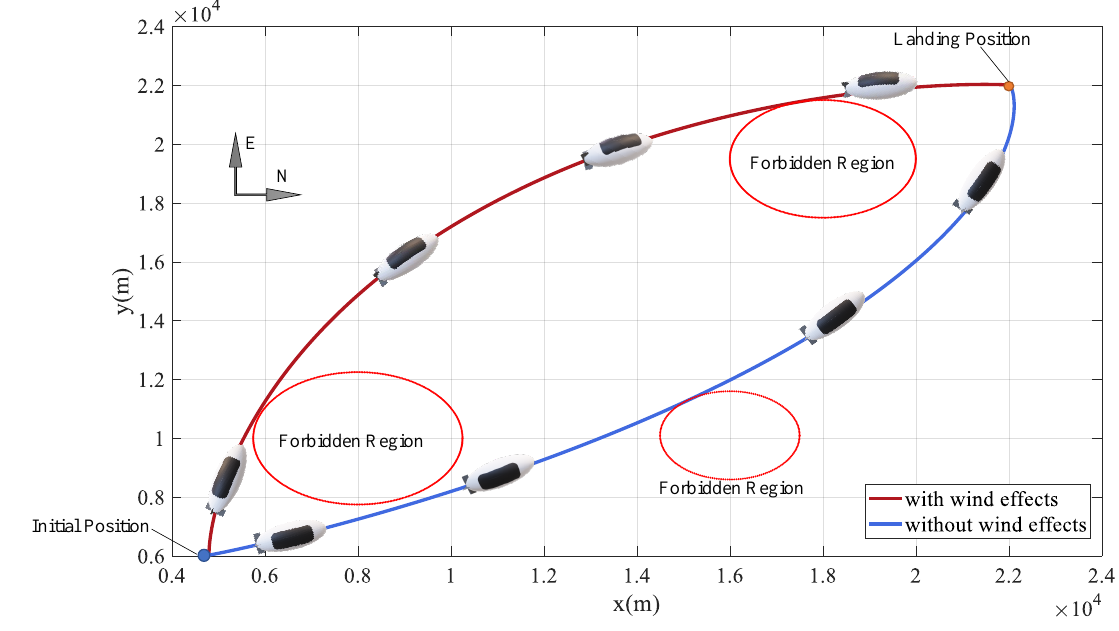
Figure 7. Top view of optimized